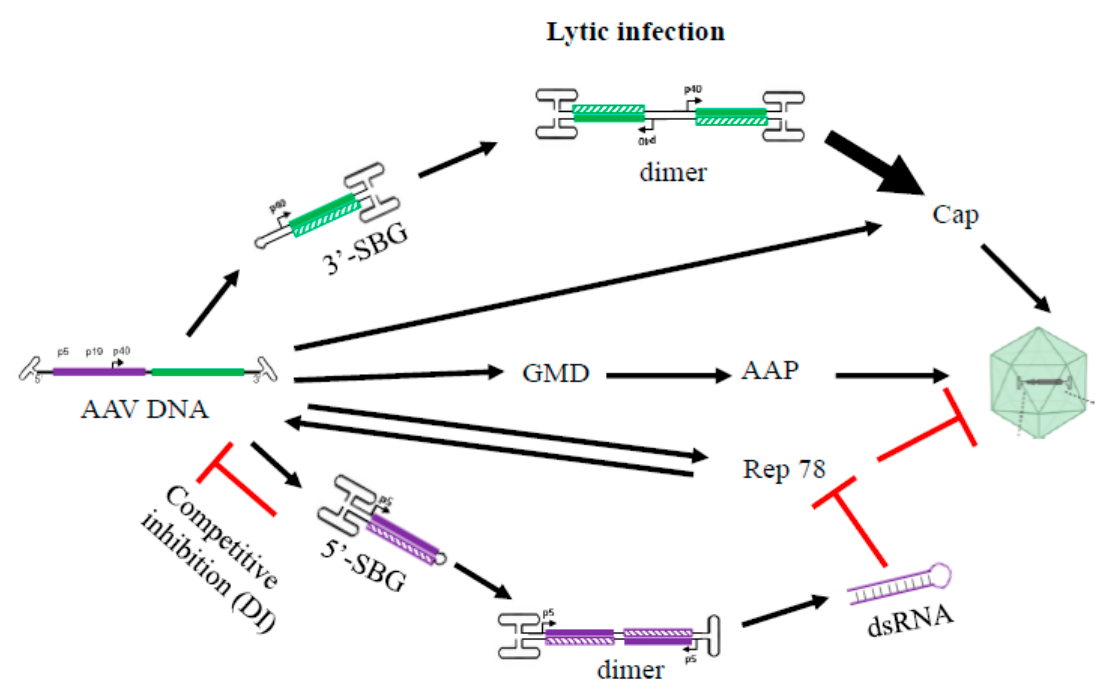
Figure 4. A hypothetical model summarizing the role of 5 (cid:48) -SBG and 3 (cid:48) -SBG in the AAV life cycle. 3 (cid:48) -SBG improves an AAV cap expression when its copy number is increased along with its double enhancer effects in dimer conformation. 5 (cid:48) -SBG may potentially express dsRNA against Rep78 . Rep78 in excess is detrimental to AAV DNA replication and package. Therefore, the relative abundance of AAV genomes and 3 (cid:48) -SBG and 5 (cid:48) -SBG may form a dedicated positive and negative loop that ensure an optimum level of production of the next generation progeny. This model provides a potential explanation that the excessive DNA template therefore requires another layer of gene regulation when there is dramatic amplification of AAV genomes during rep- lication.